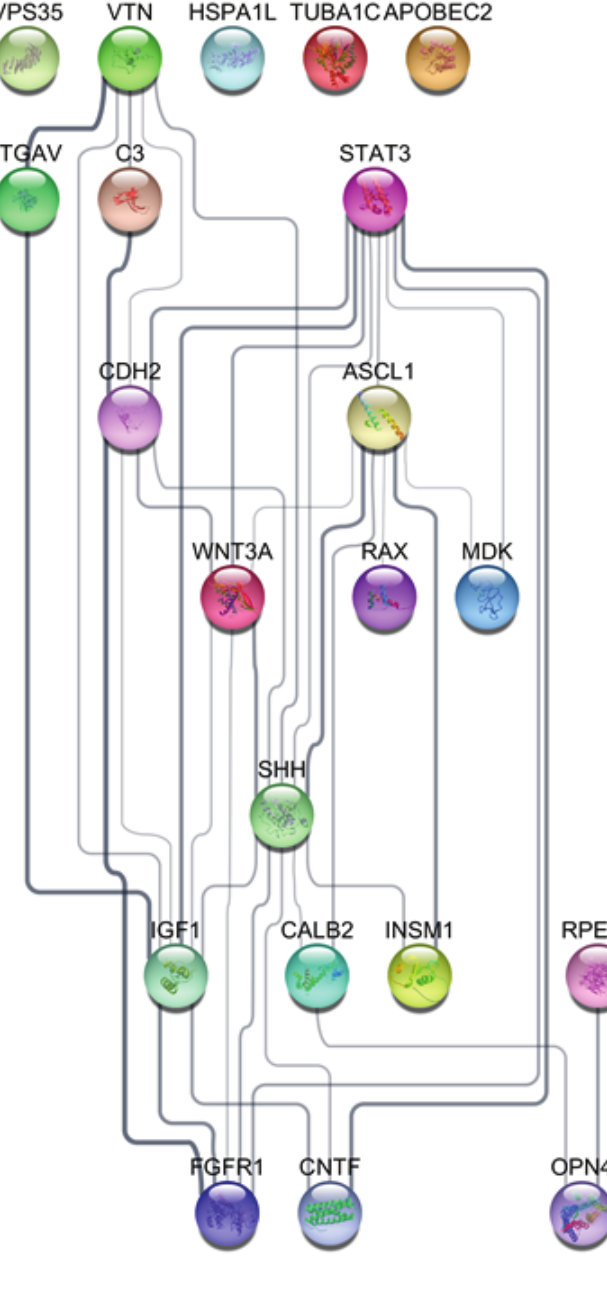
Figure 1. Hierarchical layout of the PPI network performed by STRING App in Cytoscape 3.7.2. This network presents GO analysis of retina regeneration effective growth. Each circle provides a schematic drawing of protein structure. The colors are set randomly, and the connection line’s thickness illustrates the relation of power. Also, a thicker line presents much more evidence and documents to approve the